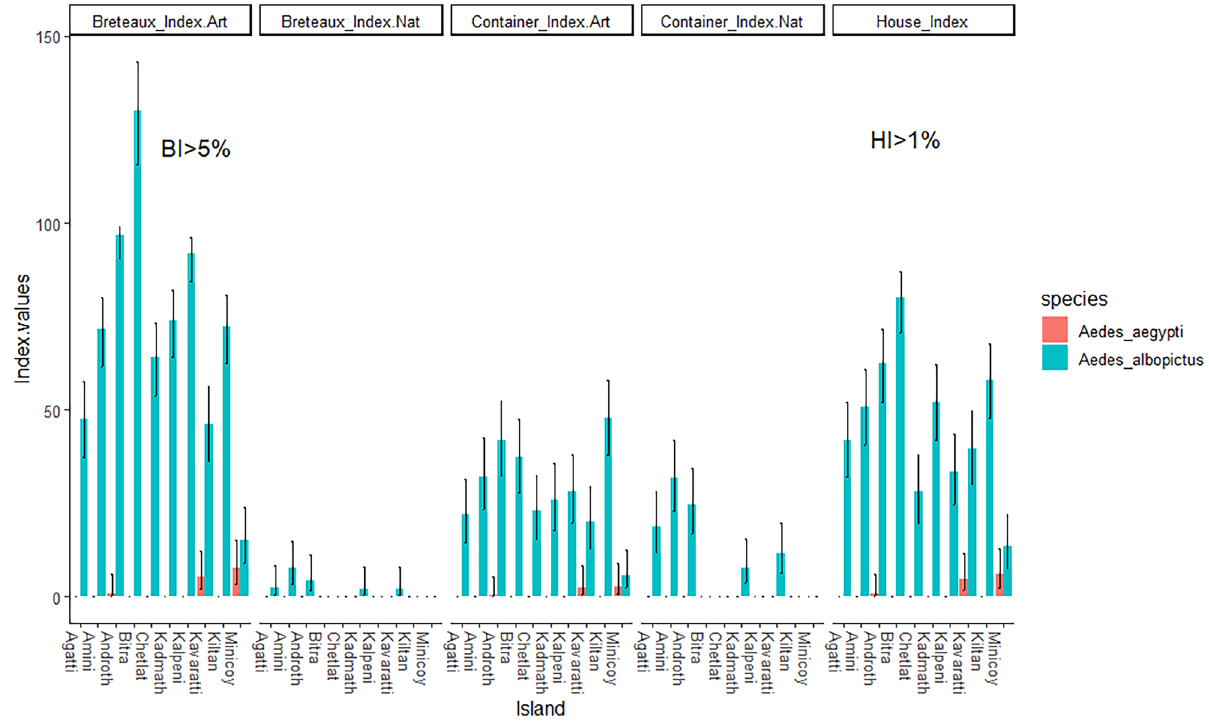
Figure 7. Aedes aegypti and Aedes albopictus infestation indices across islands. The error bars represent 95% confidence